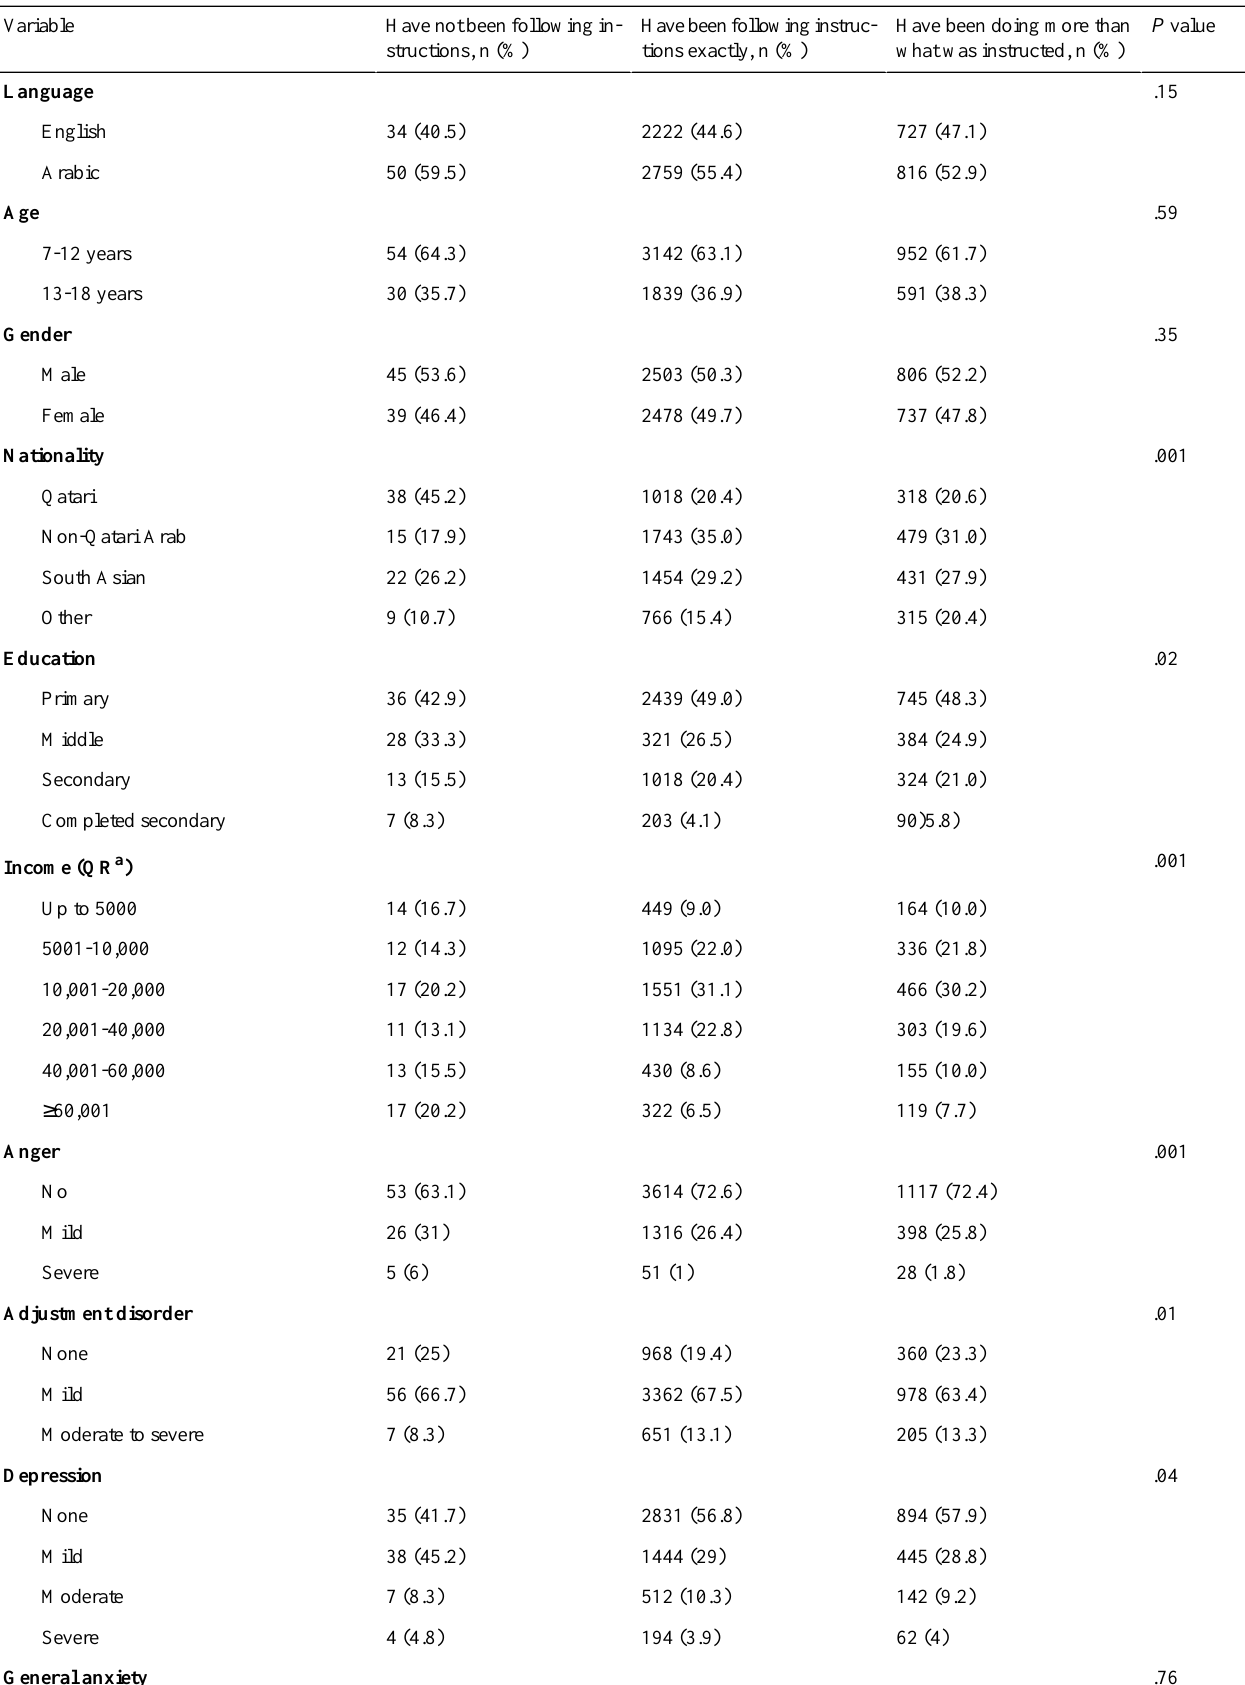
Table 4. Association between adherence to official regulations and sociodemographic characteristics of participants, final psychological diagnoses, and coping strategies used by children and adolescents in Qatar in 2020